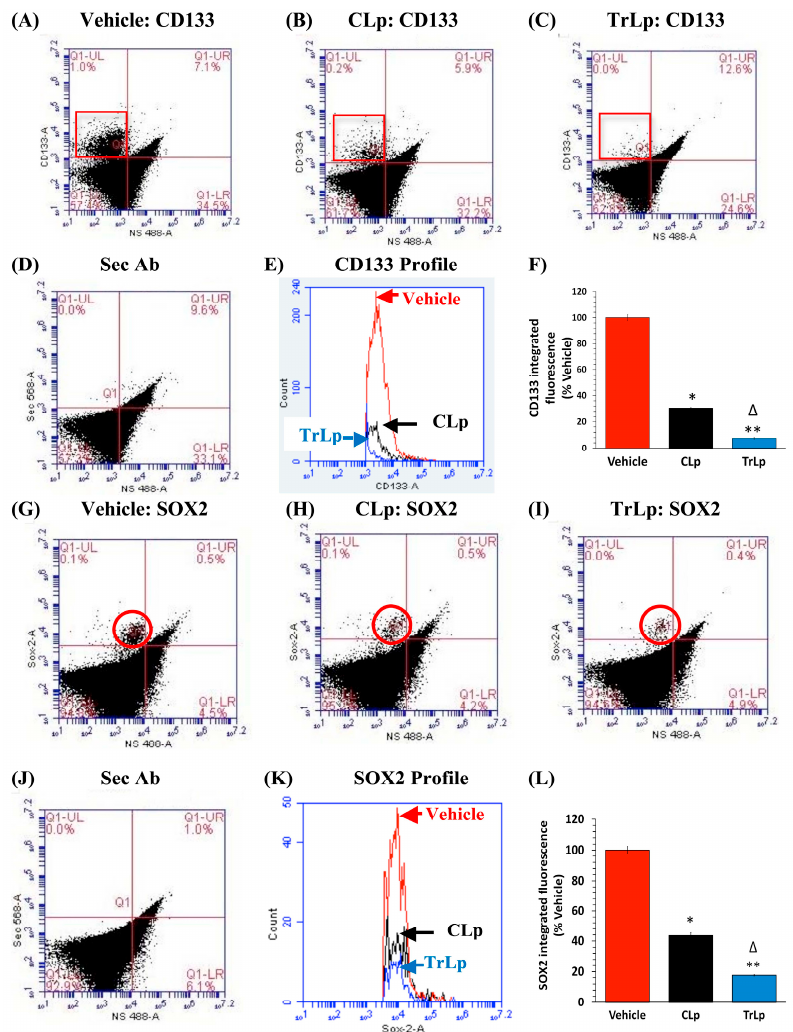
stem cells, we single-stained treated-GL261 cells with antibodies against the stem cell markers CD133 and SOX2 and performed flow cytometry analysis. CLp suppressed the CD133(+) IF by 69% (UL, red square) (Figure 4A,B,E,F), whereas TrLp reduced it by 92% (Figure 4A,C,E,F). Similarly, CLp caused a decrease in SOX2 integrated fluorescence by 56% (UL, red circle) (Figure 4G,H,K,L), whereas TrLp caused a dramatic 82% reduction in SOX2 IF (Figure 4G,I,K,L).